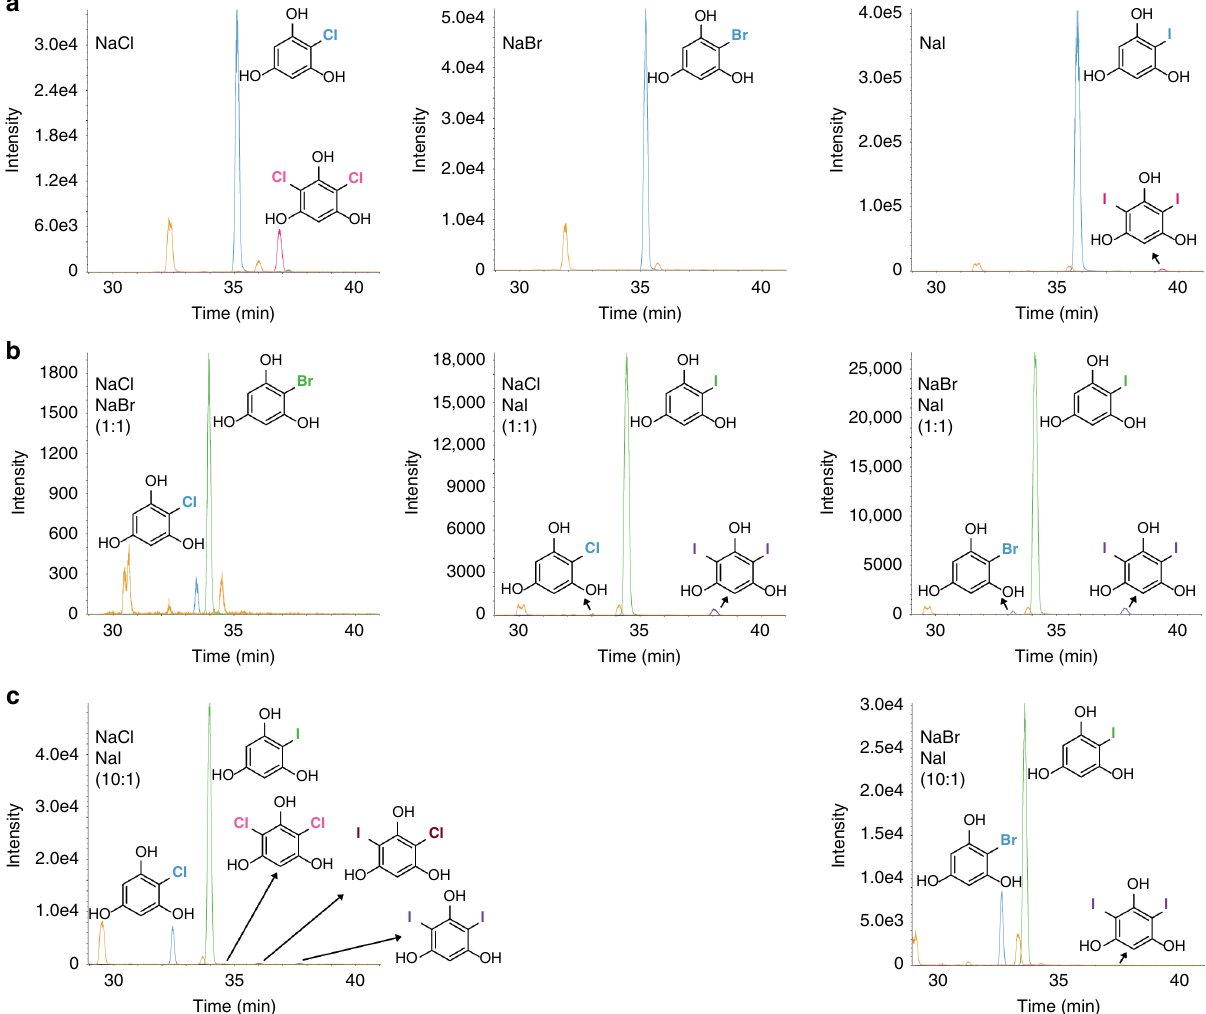
Fig. 2 Halogenation of phloroglucinol ( 1 ) by PltM. a XIC traces showing the homo-halogenation of 1 by PltM with NaCl (left), NaBr (middle), and NaI (right) as halide sources. Blue and pink traces depict mono-halogenation and dihalogenation, respectively. b Halogenation of 1 by PltM with equimolar ratio of NaCl/NaBr (left), NaCl/NaI (middle), and NaBr/NaI (right). Blue and green traces show mono-halogenation with smaller and larger halogens, respectively; while purple trace indicates dehalogenation. c Halogenation of 1 by PltM with NaCl/NaI (left) and NaBr/NaI (right) in a 10:1 ratio. Blue and green traces show mono-halogenation with smaller and larger halogens, respectively; while purple and pink traces indicate homo-dihalogenation with smaller and larger halogens, respectively. The brown trace displays hetero-dihalogenated products. The orange trace shows the unreacted substrate 1